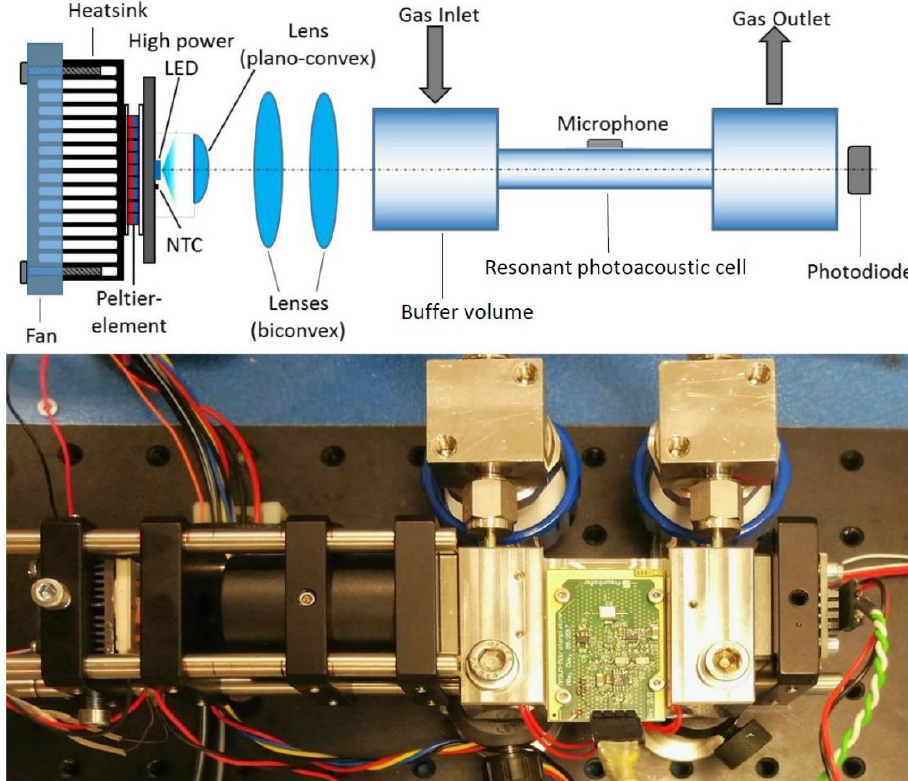
Figure 3. Setup of the developed resonant photoacoustic gas sensor. The upper part of the figure shows the sensor components in a schematic drawing. The sensor consists of the resonant photoacoustic cell with the MEMS microphone at the center of the resonator. The gas inlet and outlet are placed at the buffer volumes. The temperature of the high-power ultraviolet (UV) light-emitting diode (LED) is controlled via a thermoelectric cooler and a thermistor. The light beam is focused by optical lenses, which increases the sensitivity of the sensor system. An additional photodiode monitors the LED performance. The lower part of the figure is a photo of the corresponding developed sensor system. [16]